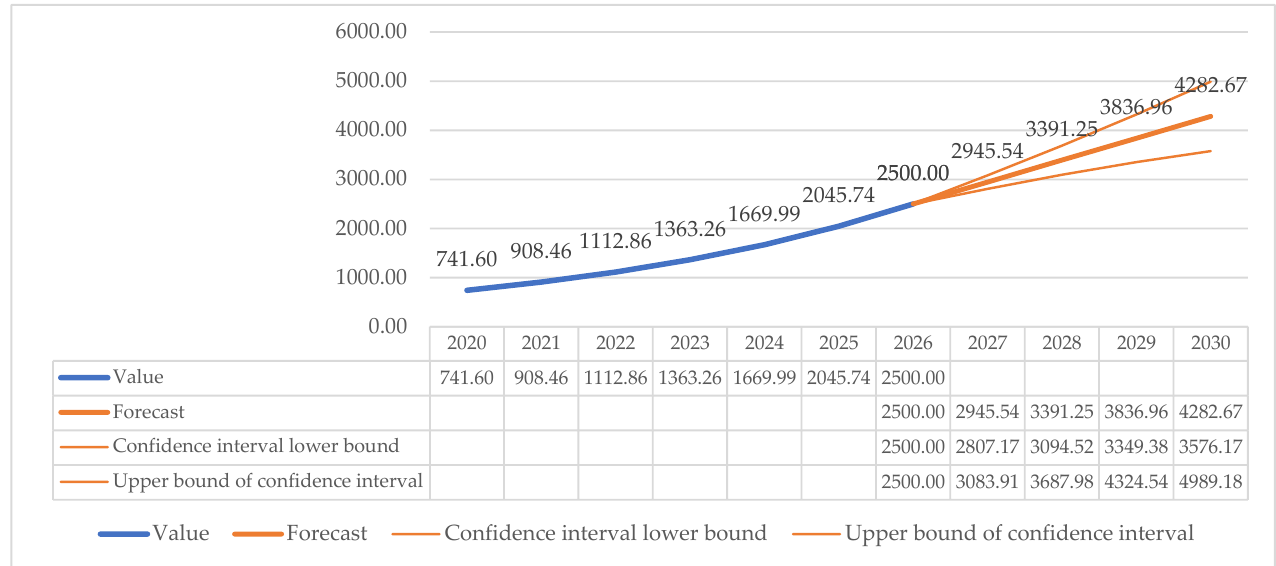
Figure 2. The value of the global market of smart city solutions and technologies in 2020 – 2030 on the basis of Research and Markets data, along with the authors’ own forecast. Source: ([82], own elaboration).